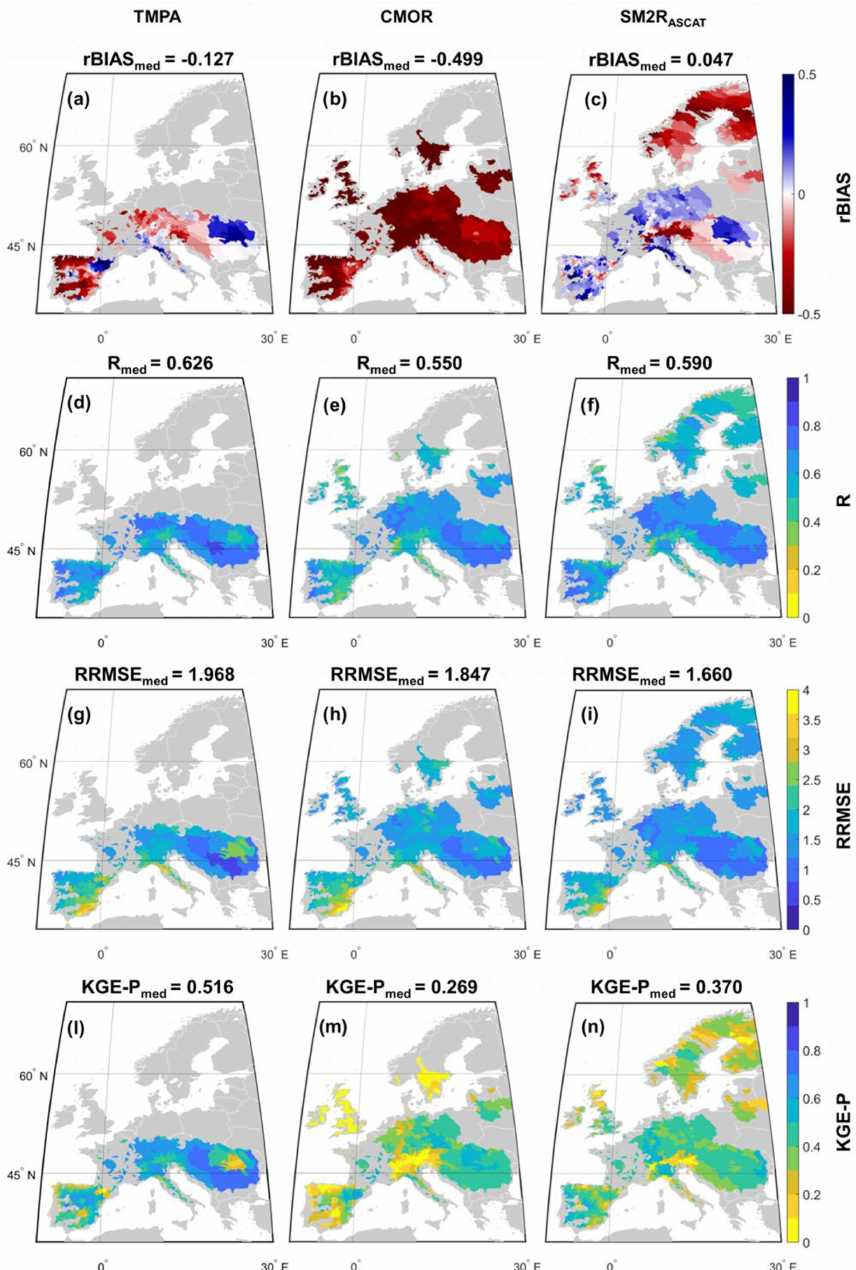
Figure 2. Performances of satellite rainfall during the validation period in terms of rBIAS (a, b, c) , R (d, e, f) , RRMSE (g, h, i) and KGE- P (l, m, n) over the study basins for the three products of TMPA (first column), CMOR (second column) and SM2R ASCAT (third column). The numbers in each plot represent the median score value obtained by considering the original spatial coverage of each